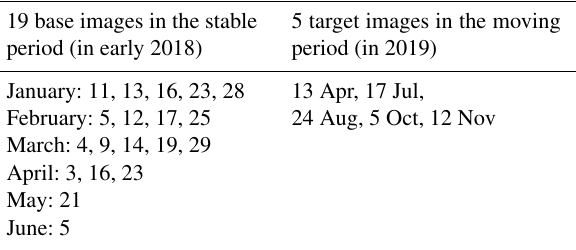
Table 1. List of the 19 base images in early 2018 and 9 targeted images in 2019. Base images were used to detect cumulative slope displacements in targeted images. Image pairs used in this step are no. 3–no. 97.